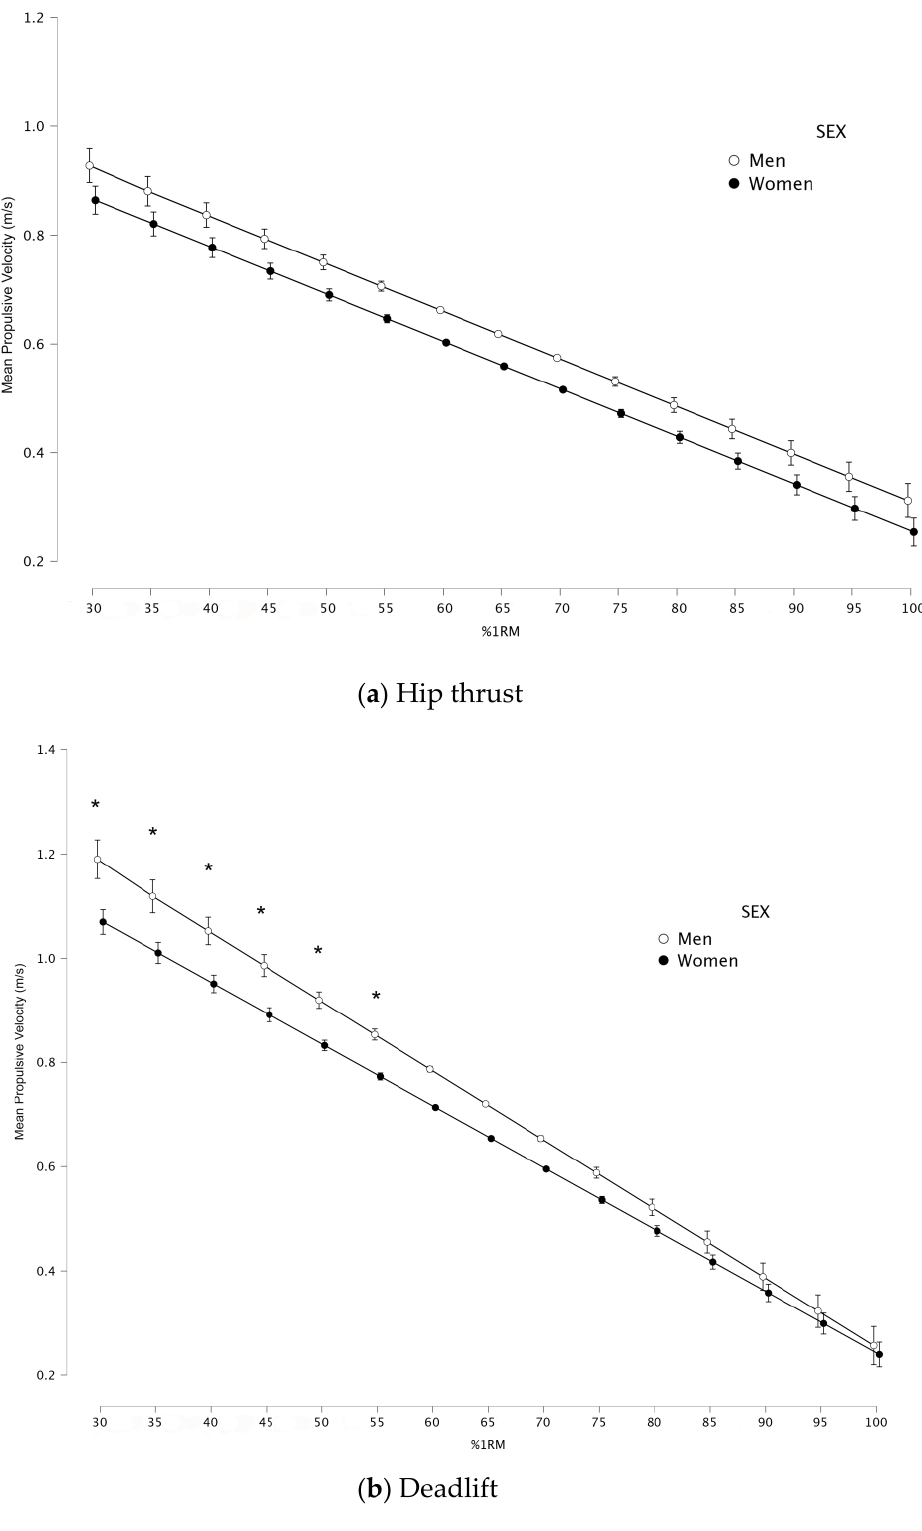
Figure 2. Relationship between relative load (%1RM) and mean propulsive velocity (MPV) for women (filled dots and solid line) and men (open dots and dashed line) in deadlift ( a ) and hip thrust ( b ) (data averaged across the participants). Significant differences between the sexes * p < 0.05.